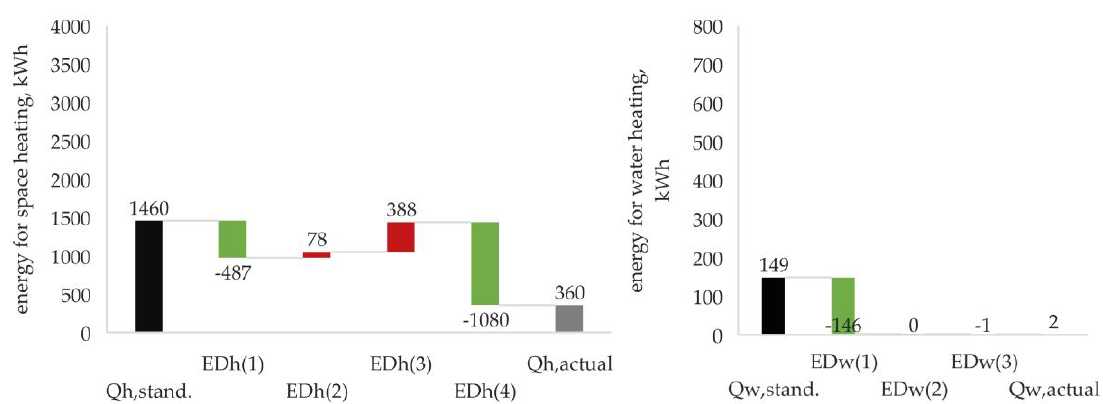
Figure 7. Influence of individual parameters on the values of energy consumption for heating ( Q h ) and hot water preparation ( Q w ) for unit C.